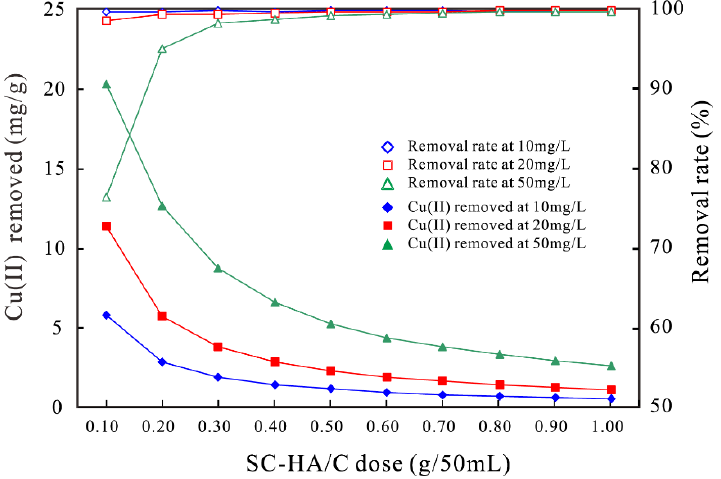
Figure 9. Influence of SC–HA/C dose on Cu (II) removal by SC–HA/C (25 °C; initial pH 5.0; initial concentration 10~50 mg/L; SC–HA/C particle size < 100 mesh).